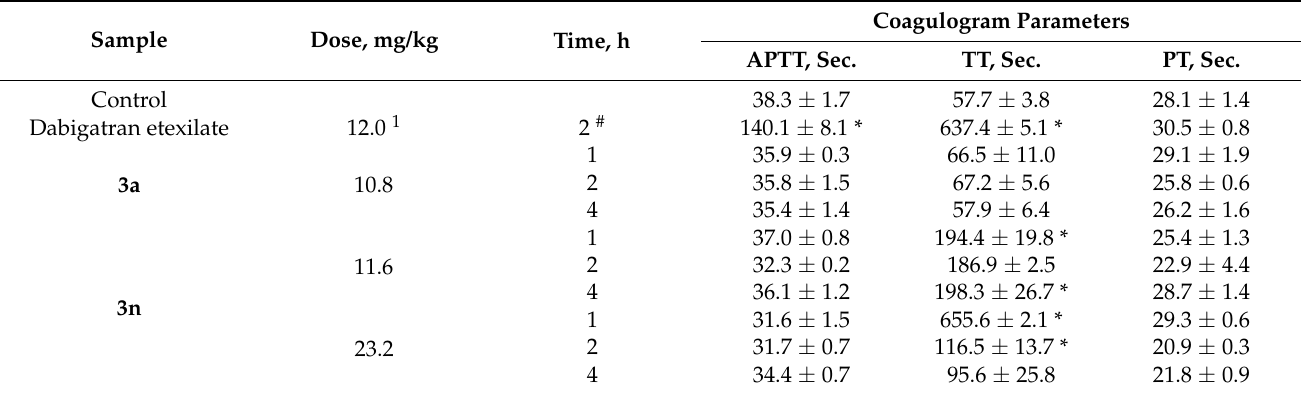
Table 8. Effect of compounds 3a and 3n on the coagulogram of rats after a single intragastric administration at various intervals in increased doses (M ± m, n = 5 ).